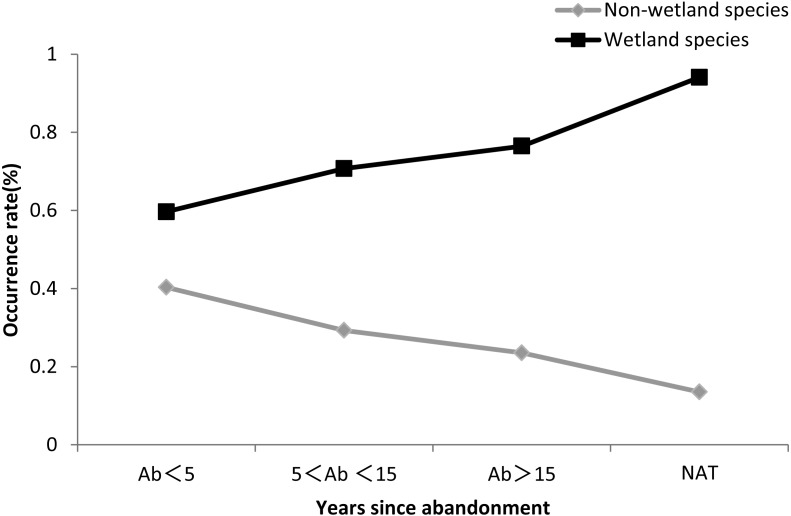
Occurrence rate of wetland species and non-wetland species.The black line indicates non-wetland species, and the gray line indicates wetland species.